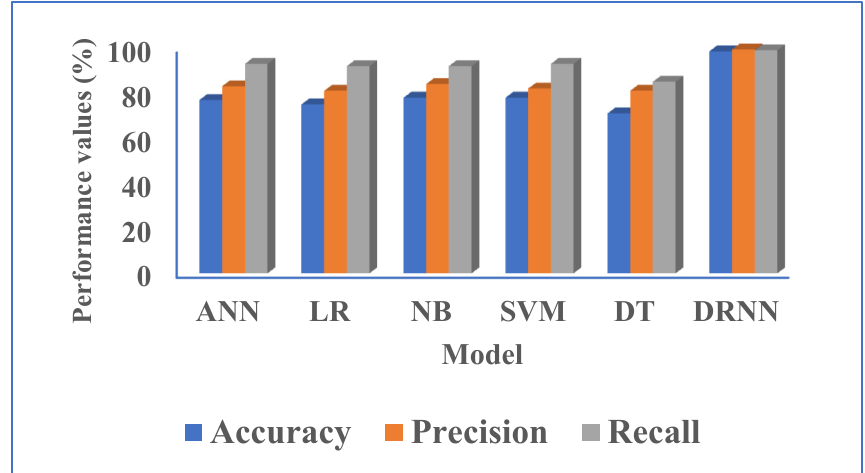
Figure 5. Accuracy, precision, and recall of existing and proposed techniques. Table 1. Accuracy, precision, and recall measures of existing and proposed techniques. Table 2. F1-scores and RMSE measures of existing and proposed techniques. Classification Techniques